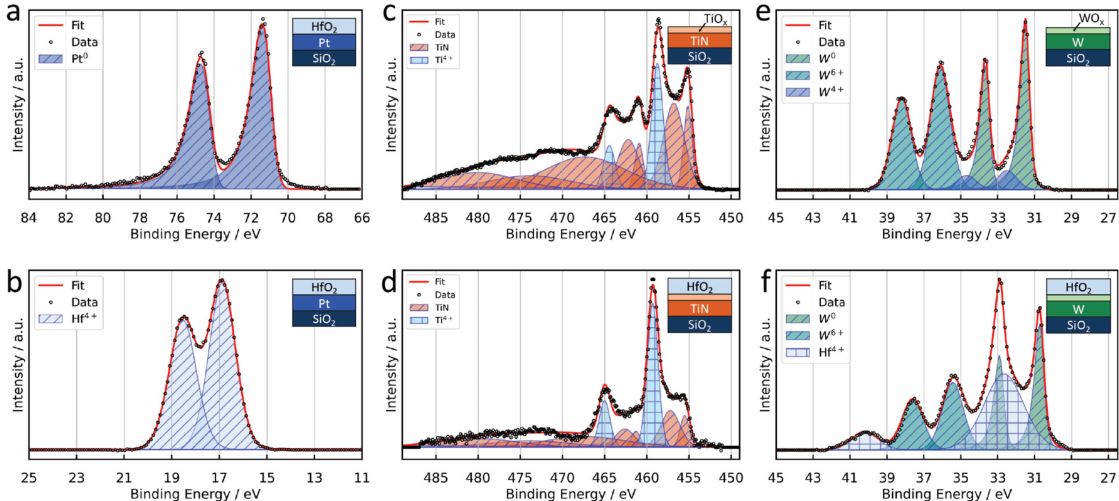
Figure 2. XPS analyses performed on different counter-electrode metal surfaces and interfaces with an HfO 2 layer on top. ( a ) Pt 4f and ( b ) Hf 4f core-level spectra for a Pt film with a 3 nm HfO 2 layer on top. ( c ) Ti 4f core-level spectra for a TiN film after exposure to air. ( d ) Ti 4f core-level spectra for a